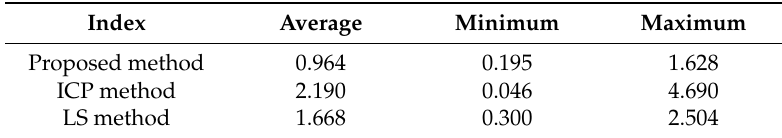
Table 3. Accuracy of the checkpoints